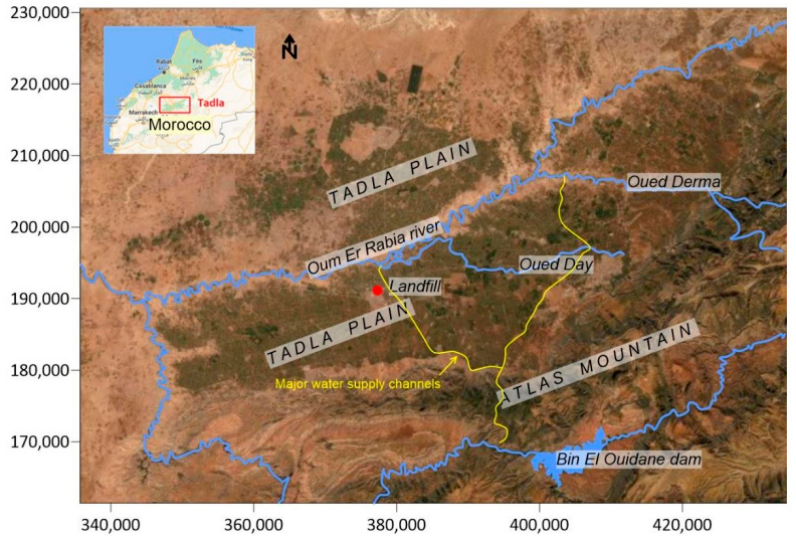
Figure 1. Geographical framework and location of the Souk Sebt landfill in the Tadla plain. UTM coordinates in meters using Lambert conical conformal projection (Morocco zone 1).